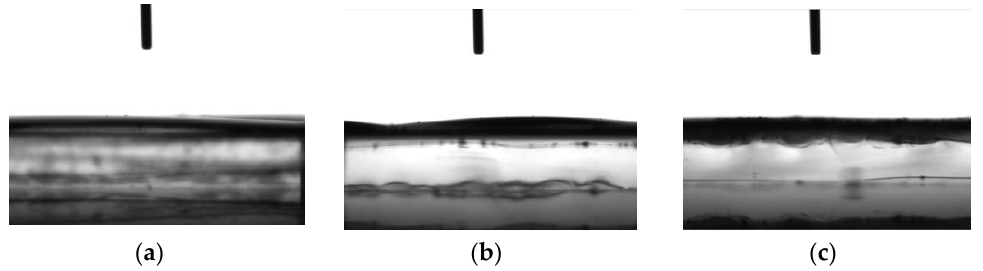
Figure 3. Goniometer pictures of ( a ) bare PES membrane, ( b ) membrane before nanoMIP immobilization, and ( c ) membrane after nanoMIP immobilization.